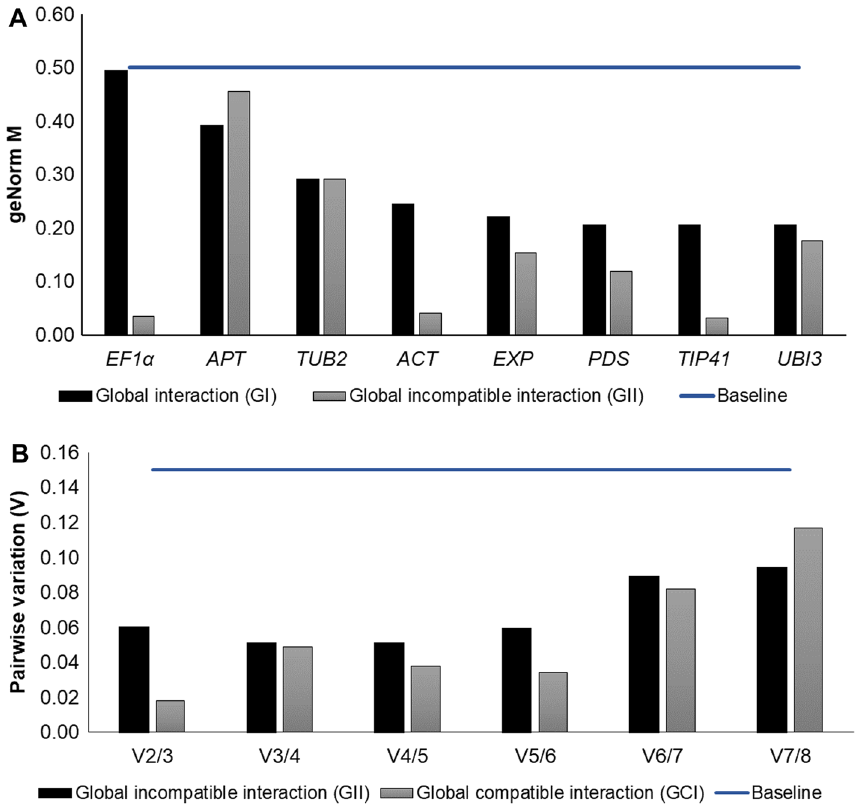
Figure 2. Stability analysis of eight tomato genes/alleles [viz. actin ( ACT ), adenine-phosphoribosyl-transferase 1 ( APT ), β-2-tubulin ( TUB2 ), elongation factor 1-alpha ( EF1α ), the Arabidopsis thaliana expressed protein ( EXP ), TIP41-interacting protein ( TIP41 ), phytoene desaturase ( PDS ), and ubiquitin ( UBI3 = UBQ )] for normalization of gene expression by RT-qPCR employed in the assays involving tomato ‘Hawaii 7996’ in interactions with incompatible/avirulent + compatible/virulent Ralstonia solanacearum isolates. Analyses were carried out with data from the Global Interaction #01 (Table 1) and the Global Incompatible Interaction #02 (see also Table 1) at 24- and 96-h post-inoculation (HPI) comparing to mock-inoculated control plants (0 HPI). ( Panel A ) average expression stability (M) and ( Panel B ) pairwise variation (V), calculated by geNorm algorithm in qBASE software. For data below a cutoff value of 0.15, the inclusion of additional reference genes will not contribute significantly to the normalization of gene expression